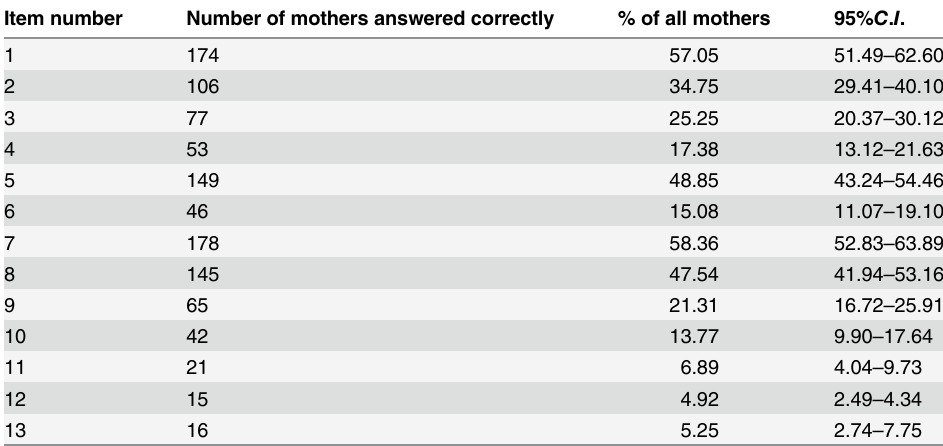
Table 4. The awareness of knowledge among population (n =